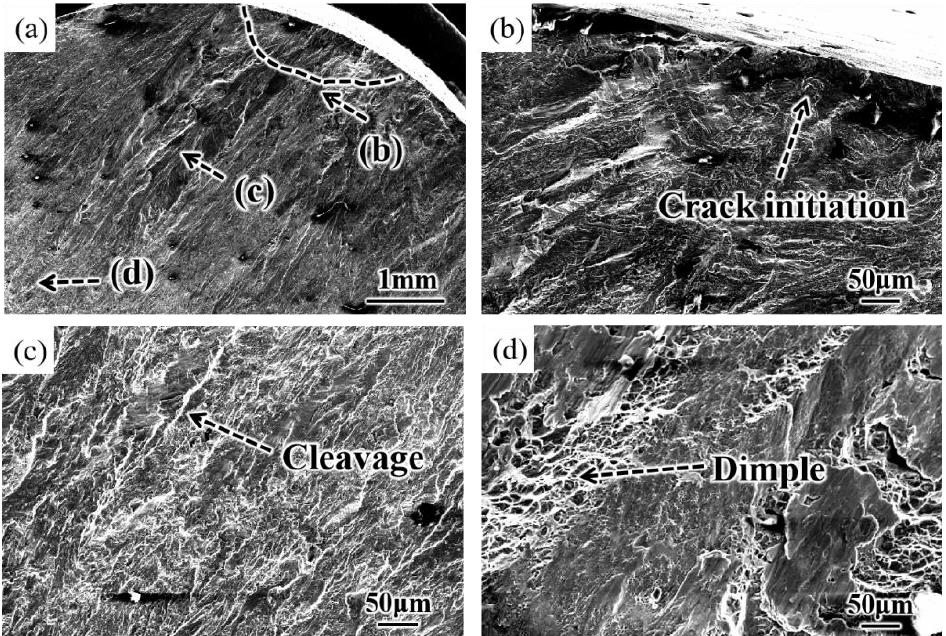
Figure 13. Fracture morphology of original sample. ( a ) Low multiplier, ( b ) crack source region, ( c ) crack propagation region, ( d ) fracture region.